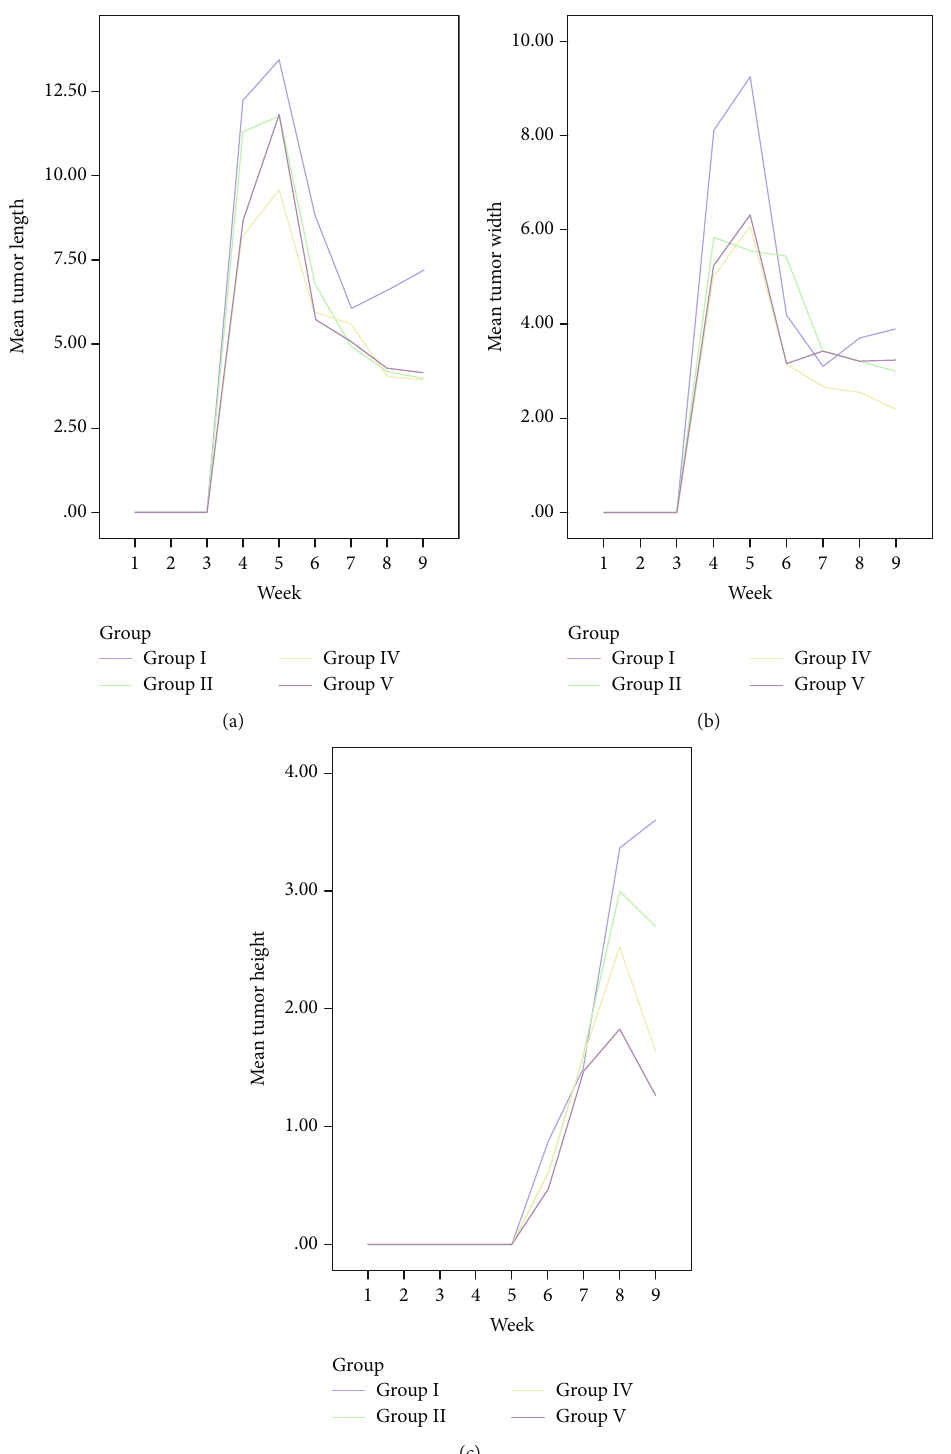
Figure 6: (a – c) Tumor measurement of experimental mice (DMBA-induced mice signi fi cantly ( p < 0 : 05 ) increased the tumor size; FA-treated mice signi fi cantly ( p < 0 : 05 ) decreased tumor